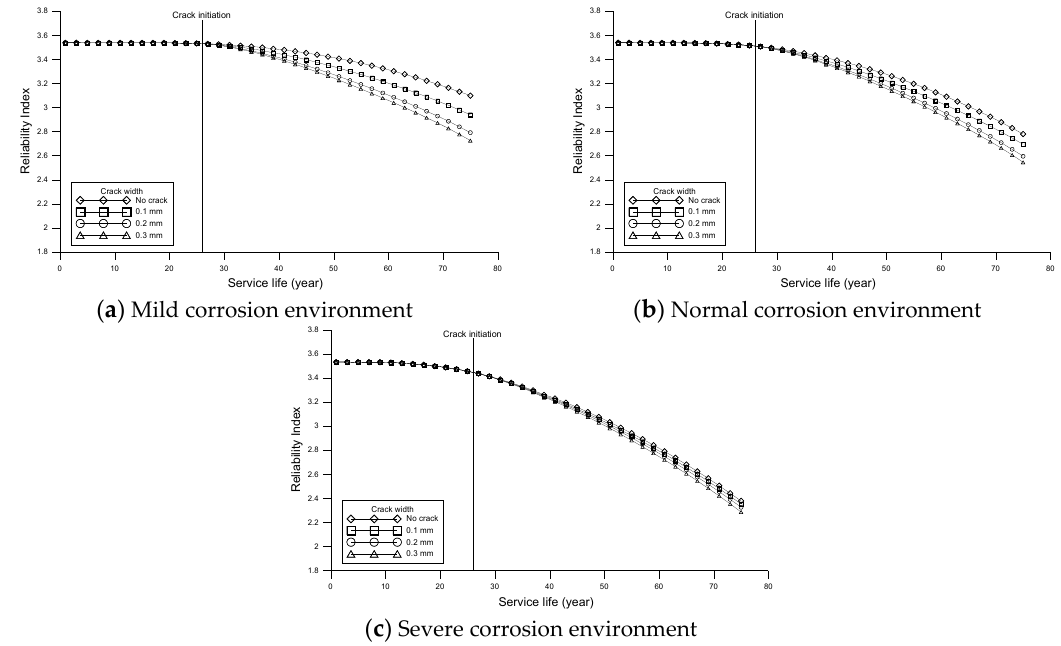
Figure 18. Reliability degradation considering crack width under normal traffic characteristics (calibrated model (2-W)).